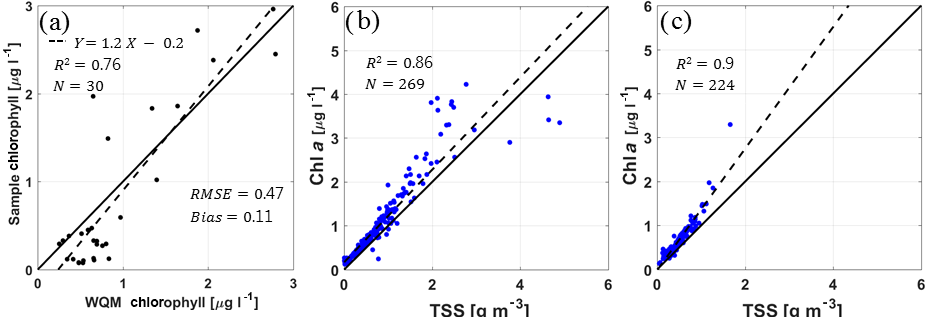
Figure 2. Results of cross-correlation ( R 2 : correlation coefficient) and linear regression analyses (dashed lines) between (a) chlorophyll fluorescence measured by the ESROB WQM and absolute chlorophyll concentration obtained from in situ water samples, and between TSS and GOCI chlorophyll a concentration for (b) the areas along and near the east coast of the Korean Peninsula and (c) area off the coast between DH and UI. The water samples (N: sample number) were collected in July and October 2011 and April